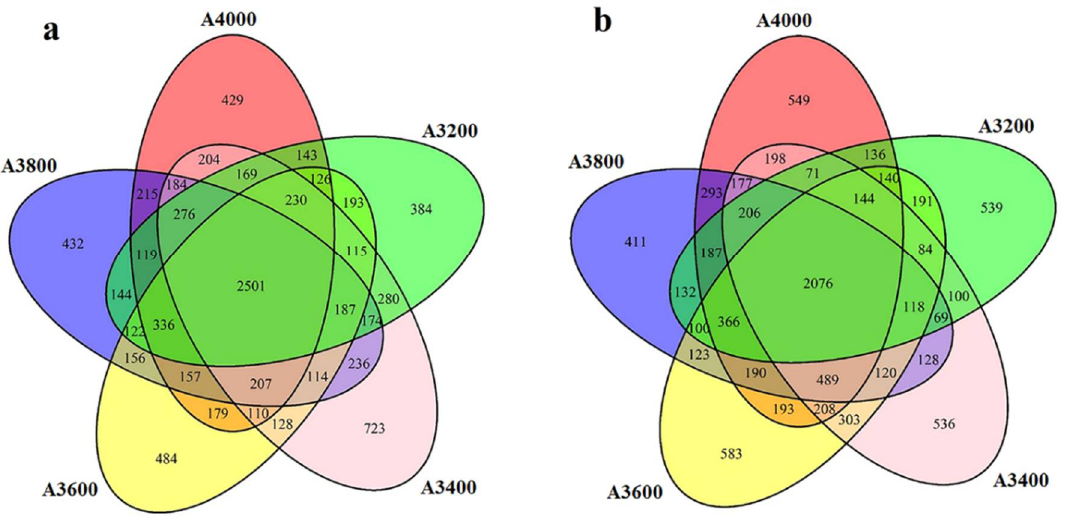
Figure 3. Shared and specific OTUs in the ( a ) topsoil (0–10 cm) and ( b ) subsoil (10–20 cm).